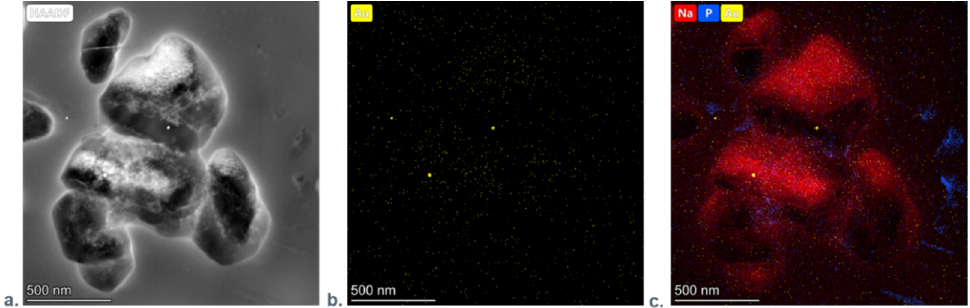
Figure 7. ( a ) STEM image of the PEI-Au-HAP; ( b ) corresponding EDX map of the Au distribution; ( c ) corresponding EDX map of the Na, P, Au distribution.